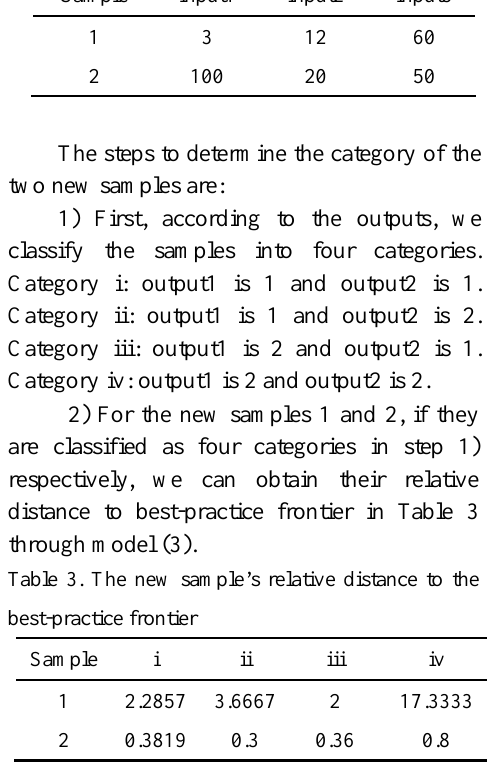
Table 2. Inputs and outputs of the new samples Sample